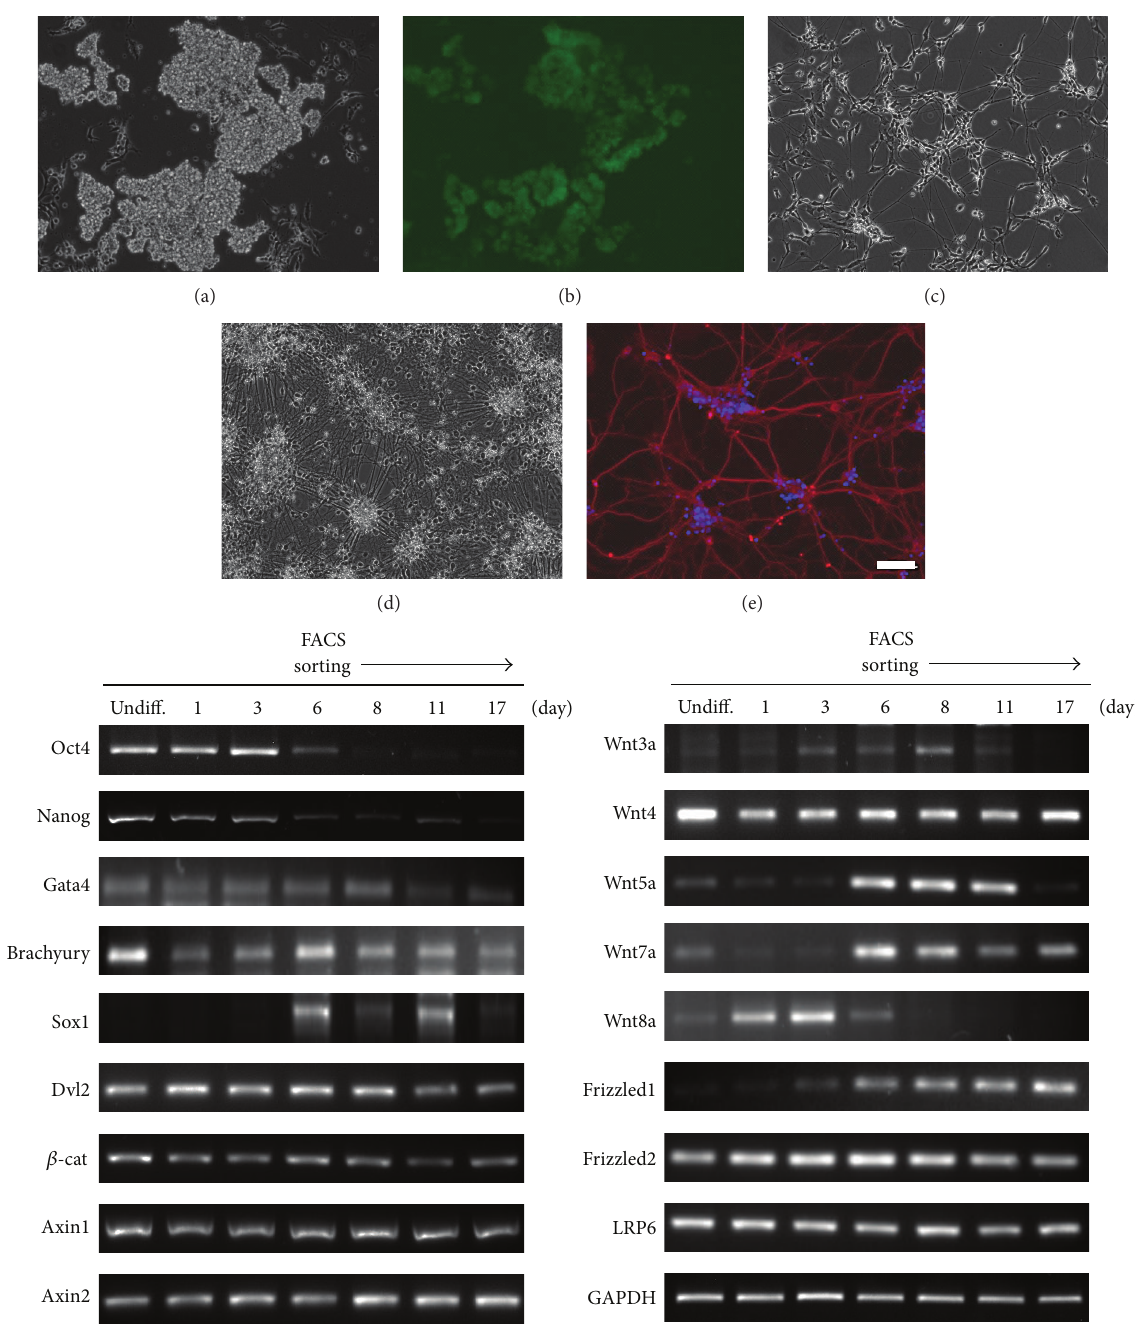
Figure 1: Neuronal differentiation of mouse embryonic stem cells and expression of Wnt and Wnt component genes. (a)–(e) Using N2B27 medium, 46C ES cells ( Sox1 -promoter-GFP) were differentiated to neuronal cells for 14 days. GFP in 46C ES cells was expressed during neuronal differentiation for 6 days ((a) phase contrast, (b) Sox1-GFP), and neurite outgrowth increased during neuronal differentiation for 8 days (c) and 14 days ((d) phase contrast, (e) MAPII (red), DAPI (blue)). (f) RT-PCR results of stem cell marker, Wnt, and Wnt signaling components during neuronal differentiation. During neuronal differentiation, RNA levels of many Wnt and Wnt signaling components were changed. Scale bars, 50 𝜇